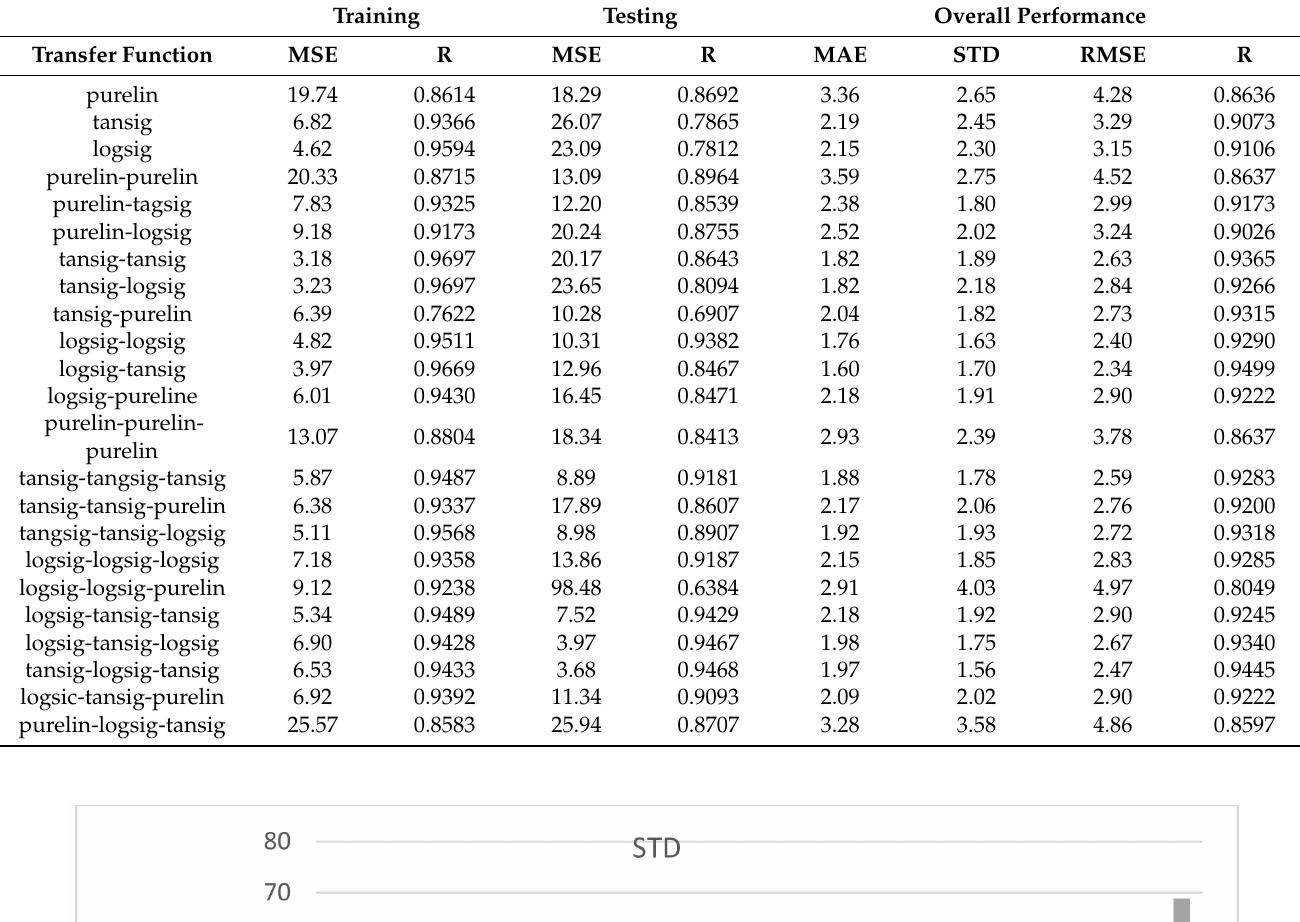
Table 4. Transfer Functions used for network training/testing and their performance.